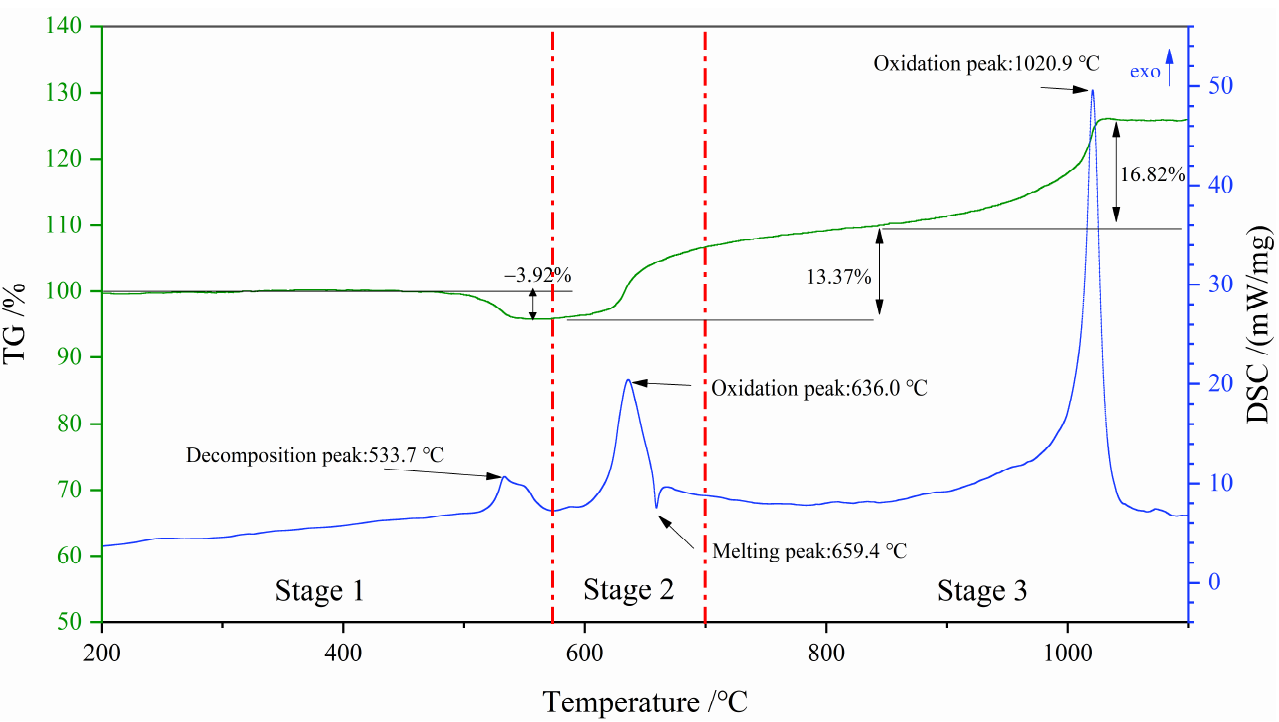
Figure 9. The TG-DSC results of the micro-nano composite aluminum powder in an argon atmosphere at 20 °C/min.